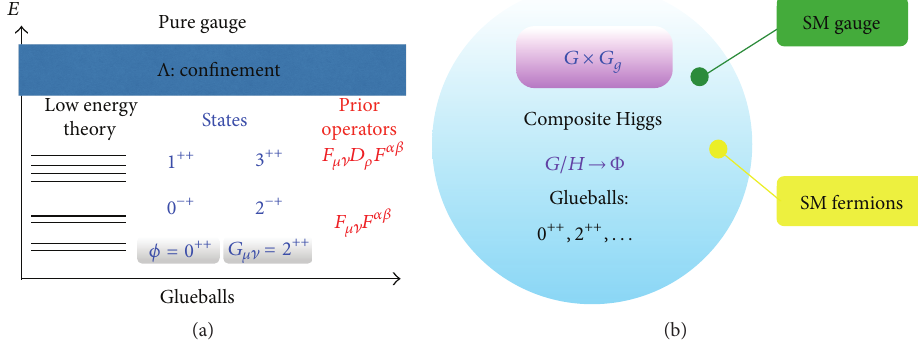
Figure 1: (a) Spectrum of glueballs in a pure gauge theory, including the prior operators. The two lightest states are singled out as 𝜙 ( 0 ++ ) and 2 ++ ). (b) The new sector of strong interactions exhibits a global symmetry 𝐺 broken spontaneously by 𝐺 𝐺 𝜇 ] (